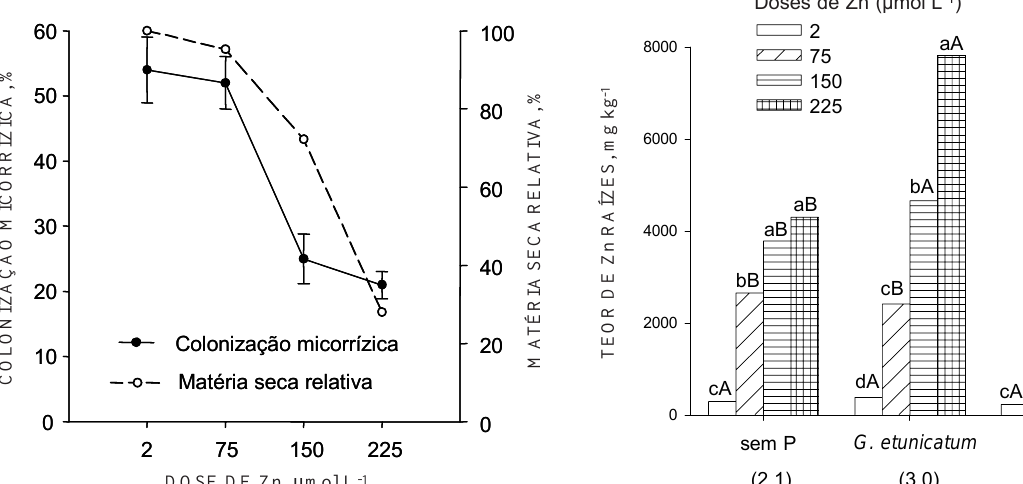
Figura 3. Relação entre a condição nutricional de P e os teores de Zn na matéria seca das raízes de Trema micrantha em solução nutritiva que con- tinha doses de Zn. Letras minúsculas compa- ram doses dentro da mesma condição nutricional de P e letras maiúsculas comparam condição nutricional de P dentro da mesma dose de Zn (Scott-Knott 5 %). * Teores de P na parte aérea em g kg